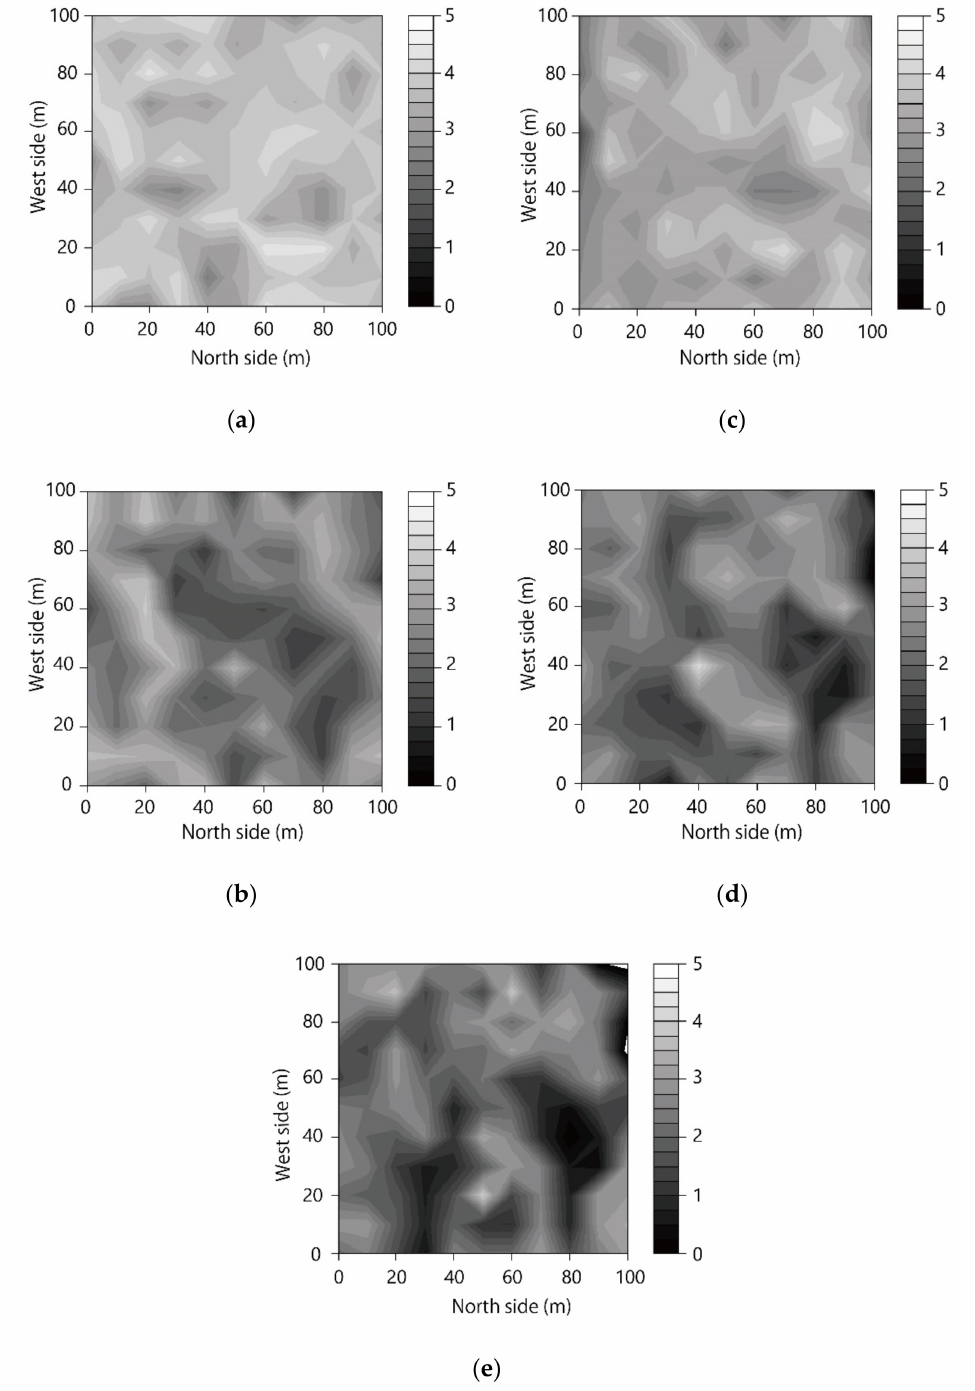
Figure 4. Spatial distribution of LAI. ( a ): LAI 0 in 2018. ( b ): LAI 2.5 in 2018. ( c ): LAI 0 in 2019. ( d ): LAI 2.5 in 2019. ( e ): LAI 5 in 2019. The axis is coordinate in study site. The contour indicates